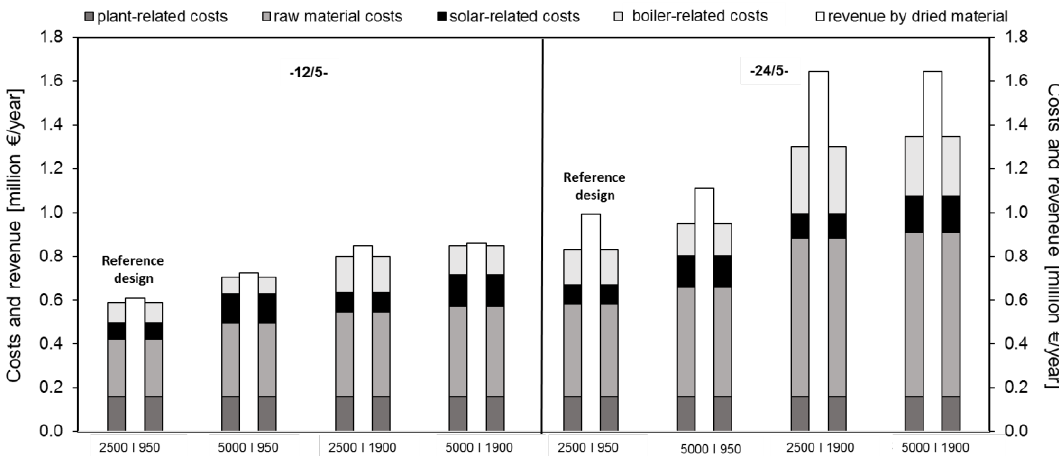
Figure 8. Comparison of costs and revenue for different plant configurations and operational strategies, i.e., 12 h/d and five days per week (12/5) as well as 24 h/d and five days per week (24/5).